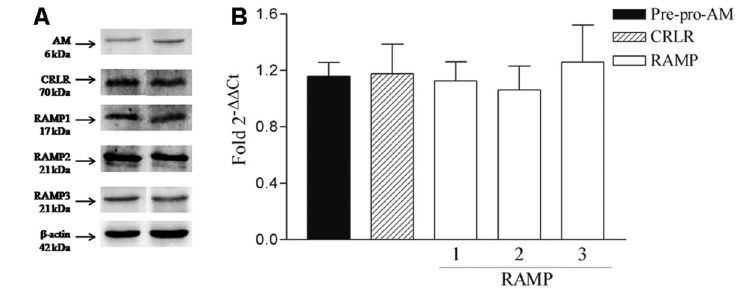
Figure 1. Protein and mRNA expression of AM system components in the rat CSM. A , Representative immunoblots for AM, CRLR and RAMP1, -2, -3 protein expression. B , mRNA expression of pre-pro-AM, CRLR and RAMP1, -2, -3 in the rat CSM was assessed by qRT-PCR. The results are reported as the expression of the individual mRNAs with normal- ization to the housekeeping gene GAPDH by using the Ct method. Data are reported as means±SE of n=5 to 7 CSM. AM: adrenome- dullin; CSM: cavernosal smooth muscle; CRLR: calcitonin receptor-like receptor; RAMP: recep- tor activity-modifying protein.